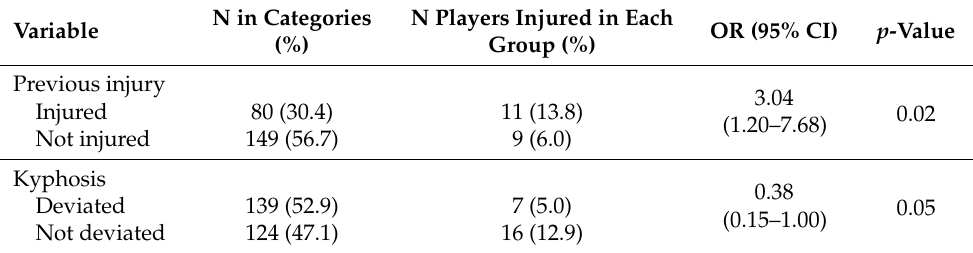
Table 6. Final multivariate model for in-season non-contact lower limb